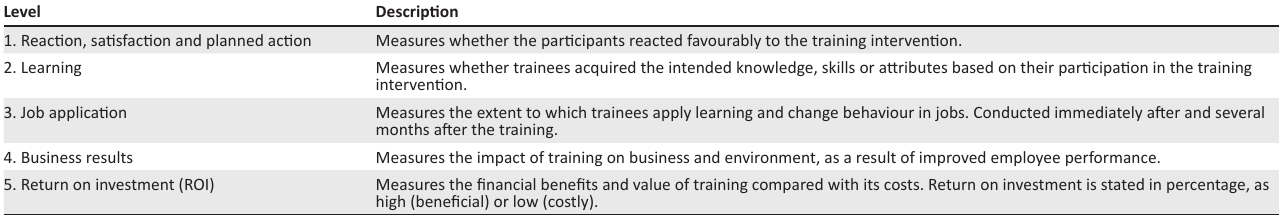
TABLE 1: The Kirkpatrick–Phillips training evaluation model. Level